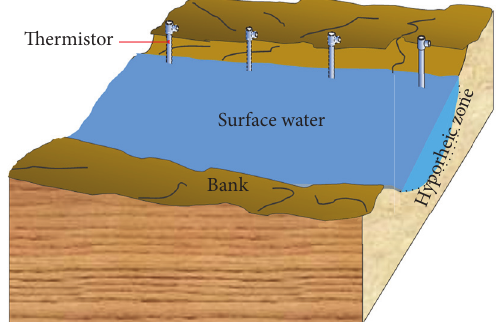
Figure 3: Collection of the temperature data along one side of the